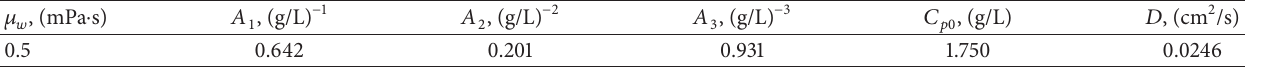
Table 2: Characteristics of polymer solutions.